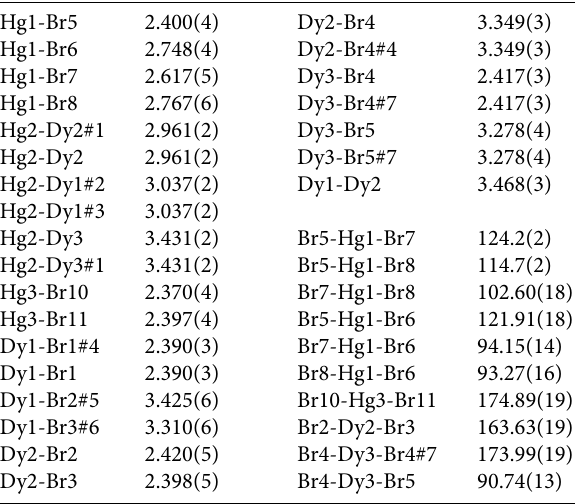
Table 2. Selected bond lengths (Å) and bond angles